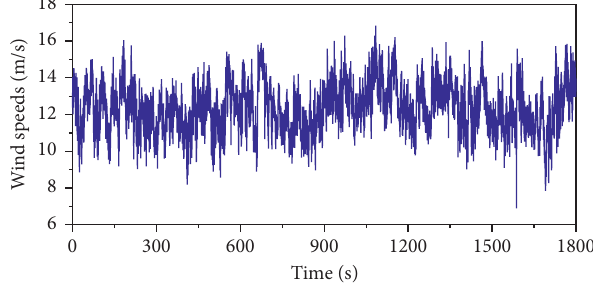
Figure 8: Wind speed time history